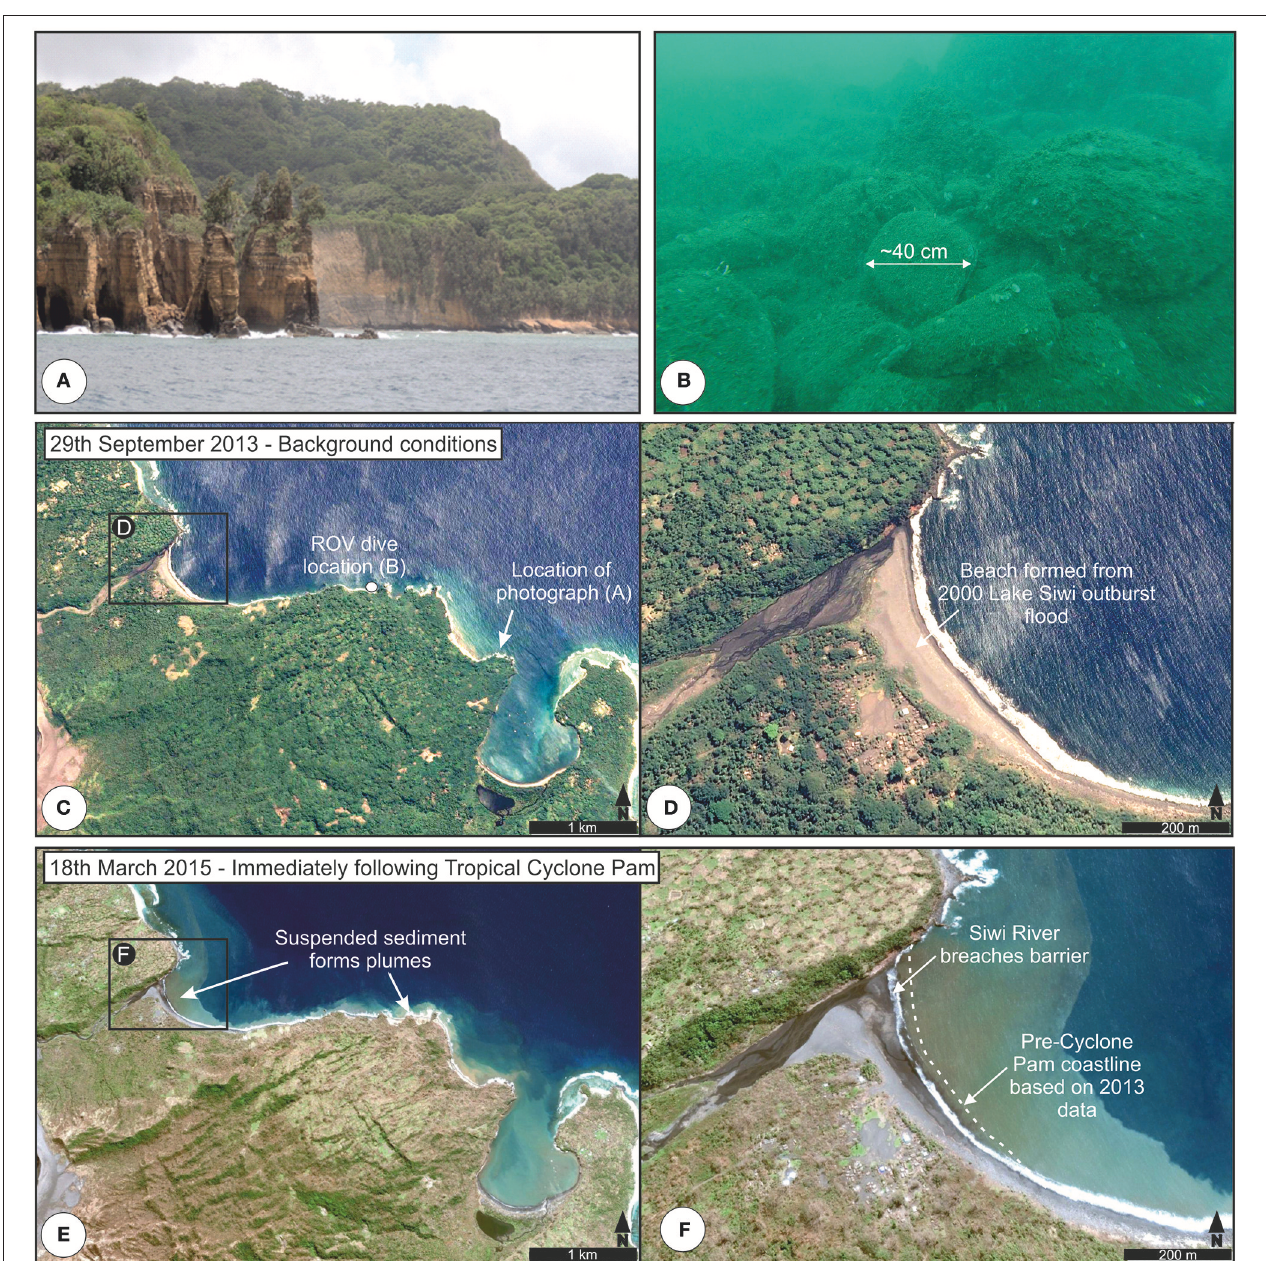
FIGURE 8 | Photograph (A) from survey vessel of steep coastal cliffs at location annotated on (C) . Photograph taken using ROV (B) showing boulders ( ∼ 30–50cm in diameter) below the cliffs. Satellite photography prior to (C,D) and immediately following (E,F) tropical cyclone Pam. (D,F) zoomed in to Siwi River and Sulfur Bay. Map images acquired by NASA and exported from Google: Digital